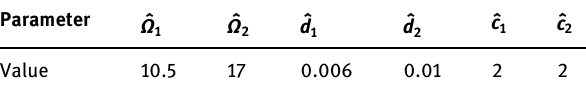
Table 4: Parameters of the NFs Parameter